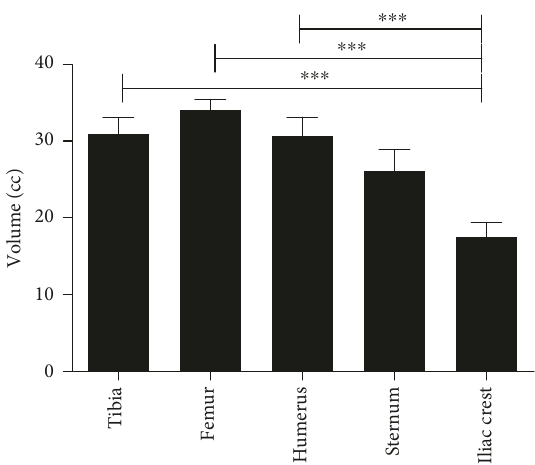
Figure 1: Volume yield of BMA from di ff erent bone marrow sites ( n = 5 ); ∗∗∗ p < 0 001